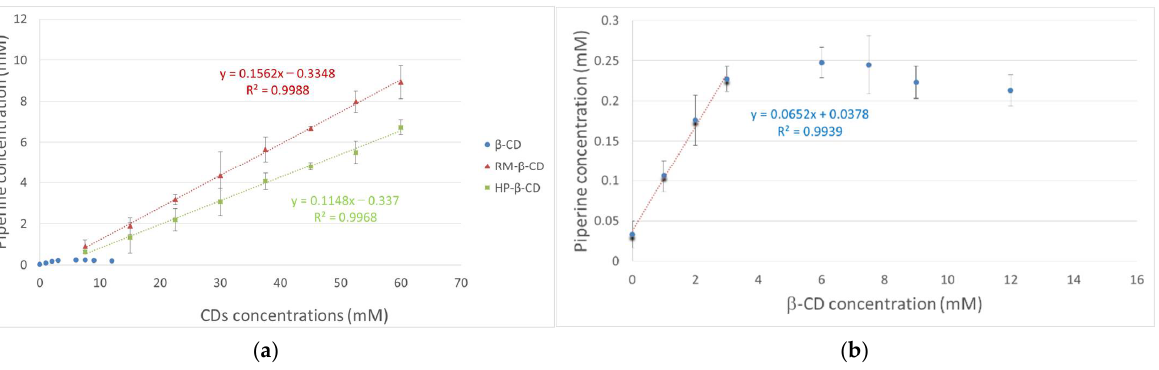
Figure 2. ( a ) Phase solubility diagrams of PN inclusion complexes with β -CD (in the range of 0–16 mM), RM- β -CD and HP- β -CD (0–60 mM) in water media at 25 °C; ( b ) PN increases linearly with increasing β -CD only in the range of 1–3 mM. ( n = 3), (●) β -CD, ( ▲ ) RM- β -CD, ( ■ ) HP- β -CD. Table 2. Stability constants K c in (M −1 ) and complexation efficiency CE (%) values of PN inclusion complexes with native and two modified β -CD derivatives at 25 °C ( n = 3).